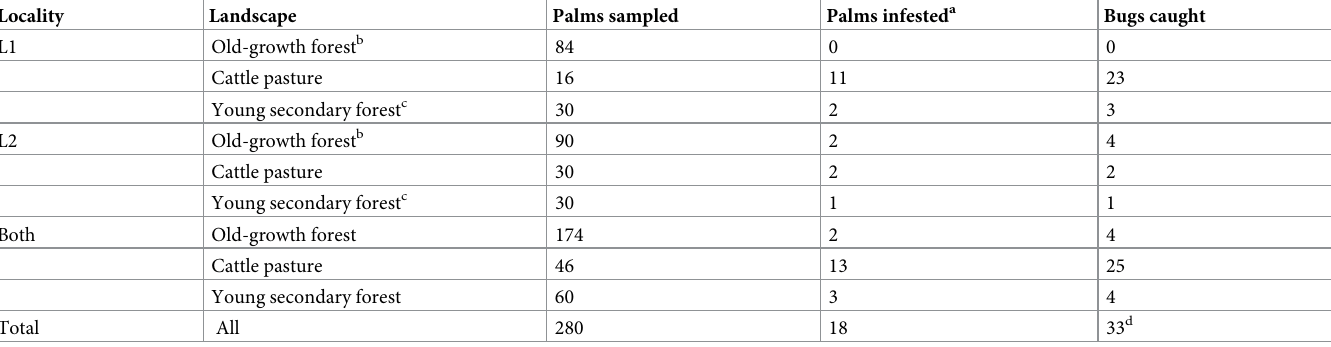
Table 2. Sampling for Rhodnius spp. in 280 adult Attalea palms: Descriptive results.